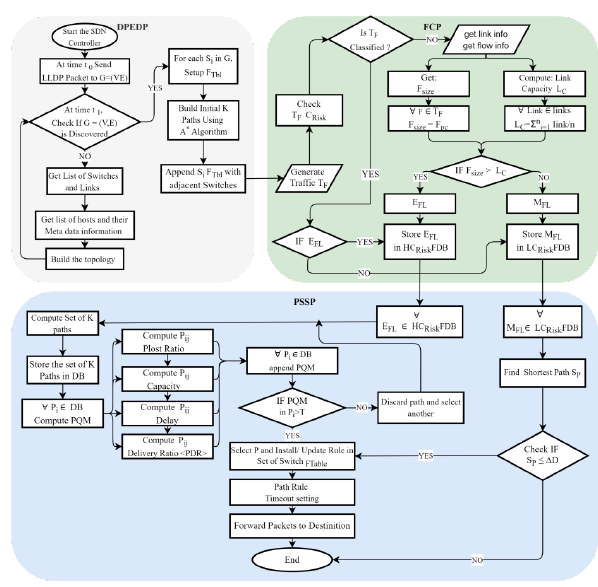
Figure 2. Flow Chart of the Proposed Algorithm.